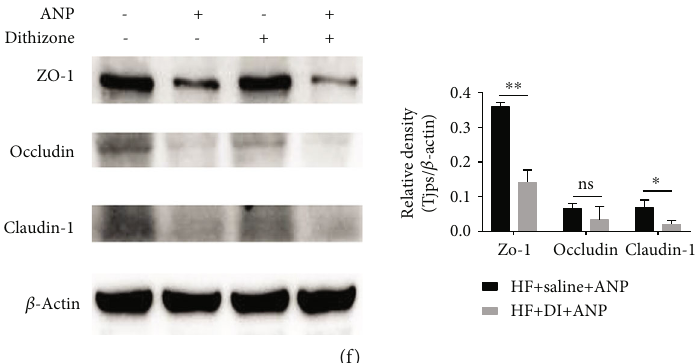
Figure 7: E ff ects of dithizone on pancreatic and intestinal injuries in rats on high-fat diet followed by retrograde sodium taurocholate infusion. (a) Sections of the pancreas and the distal ileum stained with H&E in rats treated with dithizone or saline (magni fi cation × 200). (b) Histopathological scores of the pancreas and distal ileum. (c) Serum in fl ammatory cytokines in rats treated with dithizone or saline. (d) DAO activity and serum D-lactate in rats treated with dithizone or saline. (e) Sections of distal ileum showing immunostaining for claudin-1, occludin, and zo-1 in rats treated with dithizone or saline, together with quanti fi cation of claudin-1, occludin, and zo-1 immunostaining. (f) Expression of intestinal epithelial TJPs as assessed by western blot. ∗ p < 0 : 05 , ∗∗ p < 0 : 01 , ∗∗∗ p < 0 : 001 , Student ’ s t -test. Results were expressed as the mean ± SD ( n = 5